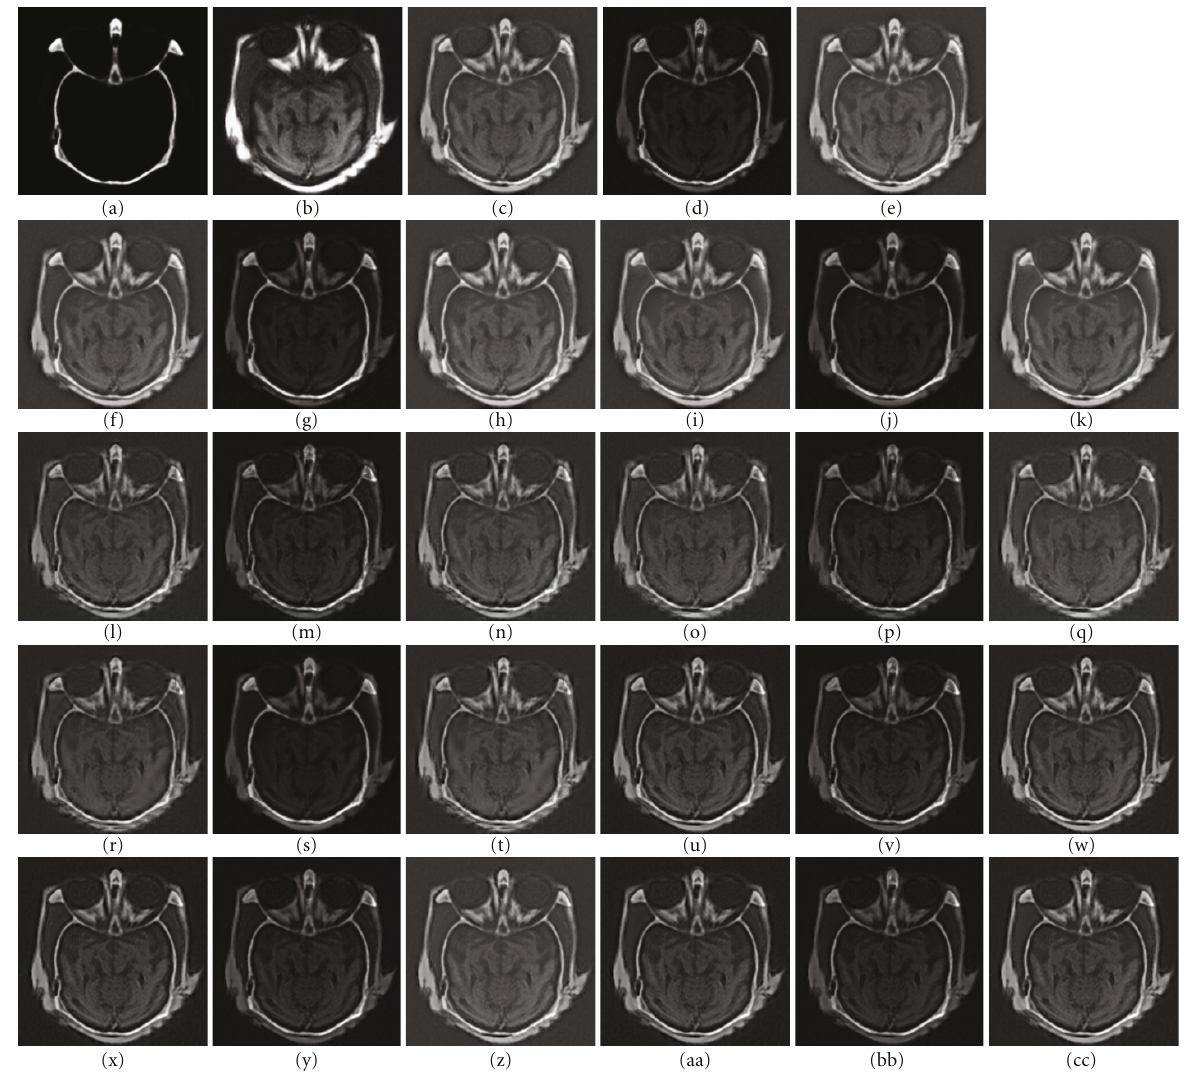
Figure 11: (a) and (b) Original “brain” source images, image fusion results using (c) LP/AM, (d) LIP-LP/AM, (e) PL-LP/AM, (f) LP/BK, (g) LIP-LP/BK, (h) PL-LP/BK, (i) LP/RB, (j) LIP-LP/RB, (k) PL-LP/RB, (l) DWT/AM, (m) LIP-DWT/AM, (n) PL-DWT/AM, (o) DWT/BK, (p) LIP-DWT/BK, (q) PL-DWT/BK, (r) DWT/RB, (s) LIP-DWT/RB, (t) PL-DWT/RB, (u) SWT/AM, (v) LIP-SWT/AM, (w) PL-SWT/AM, (x) SWT/BK, (y) LIP-SWT/BK, (z) PL-SWT /BK, (aa) SWT/RB, (bb) LIP-SWT/RB, (cc) PL-SWT/RB.